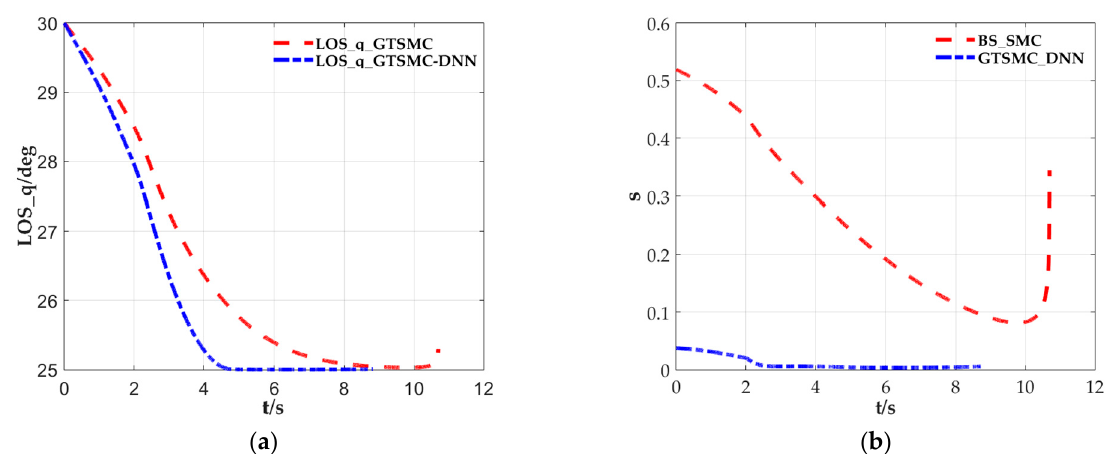
Figure 13. ( a ) The maneuver characteristics of the target; ( b ) The missile–target pursuit trajectory.